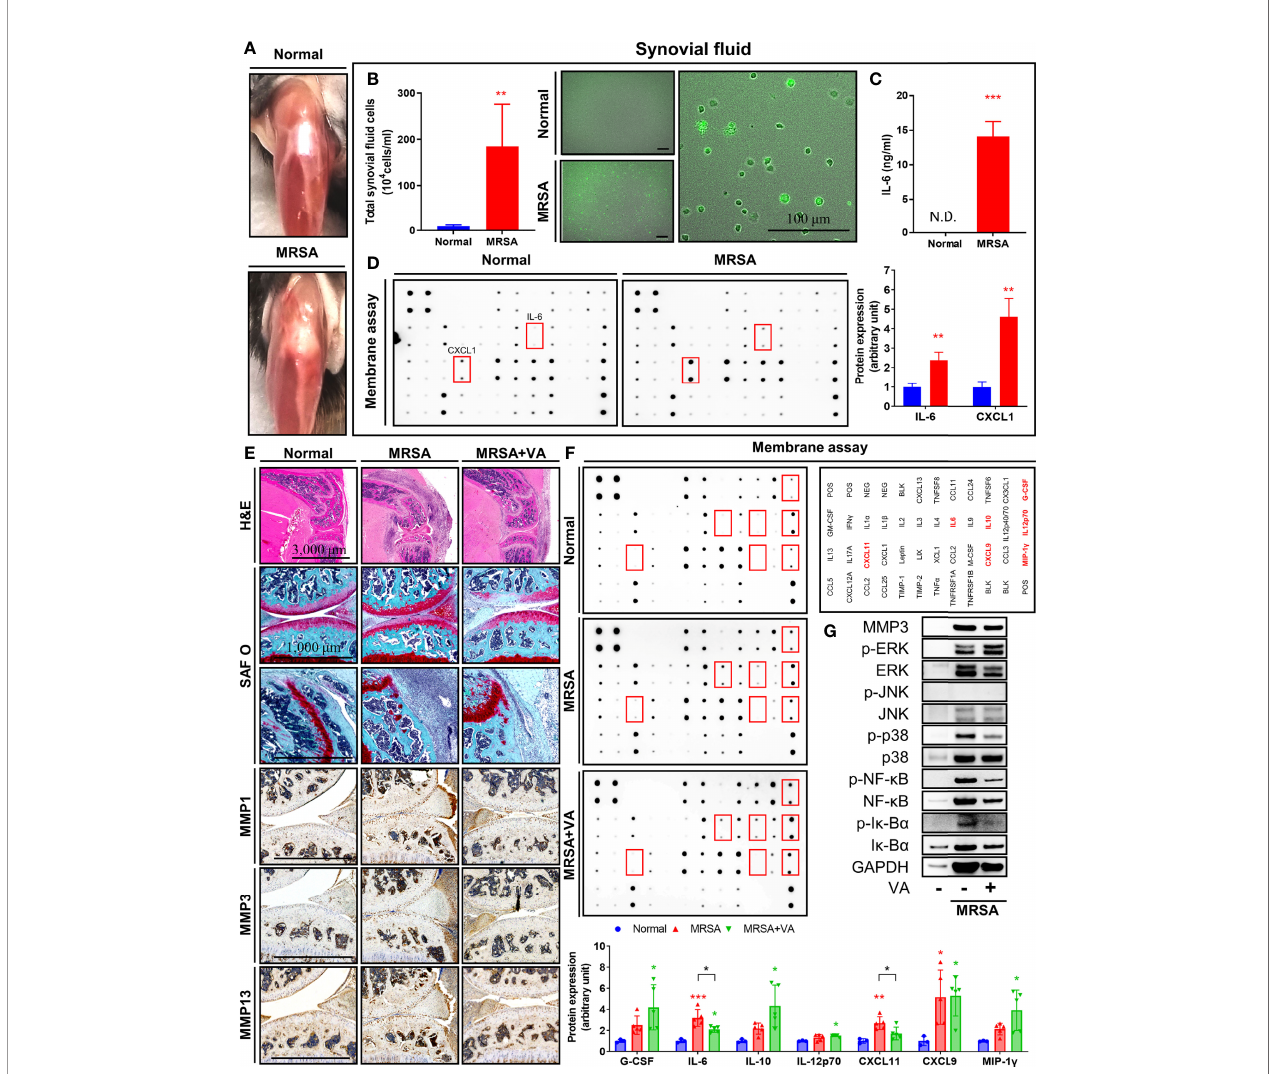
FIGURE 4 | Intracellular MRSA persisted in synovial cells and ERK-mediated in fl ammation remained despite conventional vancomycin treatment. (A – D) C57BL/6 mice received intraarticular knee joint injections of MRSA (4×10 6 CFU/10 m L), with analysis performed at one day post-infection ( n = 3 per group). (A) Representative images of partially dissected knees. (B, C) Synovial fl uid collected from knee joint in normal and MRSA infection. (B) Quanti fi cation of total synovial fl uid cell count between normal and MRSA-infected mice (Scale bar: 100 m m). (C) The concentration of synovial IL-6 was quanti fi ed using ELISA. (D) Pro fi les of synovial pro- in fl ammatory factors were measured via membrane assays. (E – G) C57BL/6 mice were injected with MRSA (4×10 6 CFU/10 L) into the knee joint. One day after infection, vancomycin (VA; 30 mg/kg) was subcutaneously injected for 3 days until eventually being sacri fi ced at 14 days post-inoculation ( n = 3-4 per group). (E) Paraf fi n-embedded knee joint tissues were sectioned and that histologically stained with H&E and SAF O (Scale bar: 3,000 and 1,000 m m). Expression of MMP1, MMP3, and MMP13 was measured in paraf fi n-embedded knee joint tissues using immunohistochemistry assay. (F) Pro fi les of synovial pro-in fl ammatory factors were measured via membrane assays. (G) Expression of MMP3, p-NF- k B, NF- k B, p-I k -B a , I k -B a , p-ERK, ERK, p-JNK, JNK, p-p38, and p38 in whole protein extracted in synovial tissues were measured; GAPDH was used as a loading control. Error bars show means ± SD. One-way ANOVA with Tukey ’ s post hoc analysis or two- tailed unpaired t -test analysis were used to assess statistical signi fi cance when compared to the normal group or MRSA group (* p <0.05 or ** p < 0.01 or *** p < 0.001; N.D., not